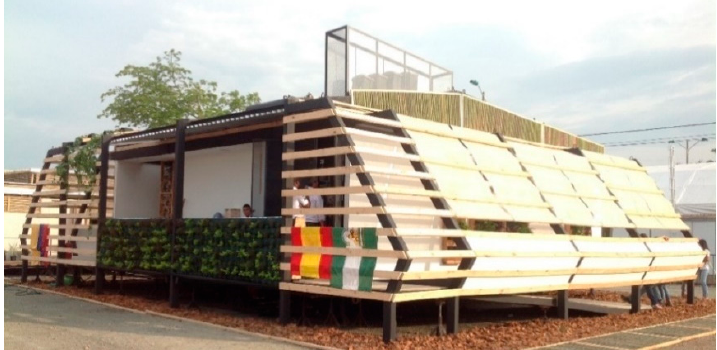
Figure 16. Photo of the north-east facade.